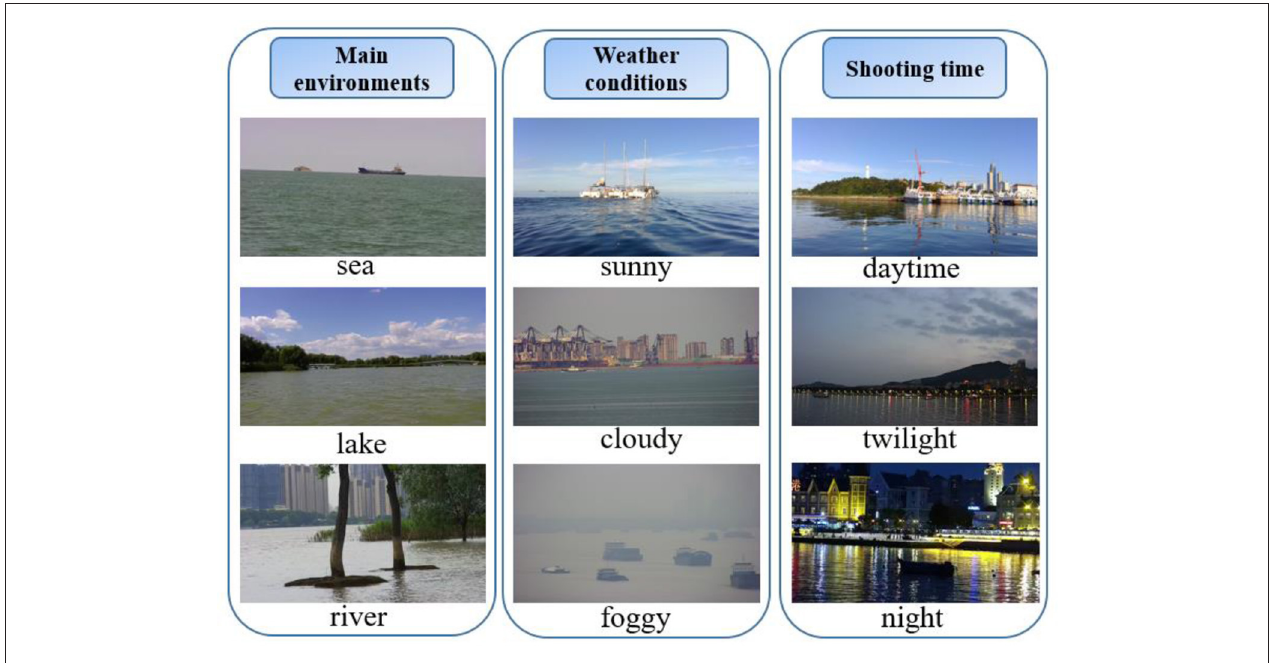
FIGURE 1 | Typical environments and conditions in